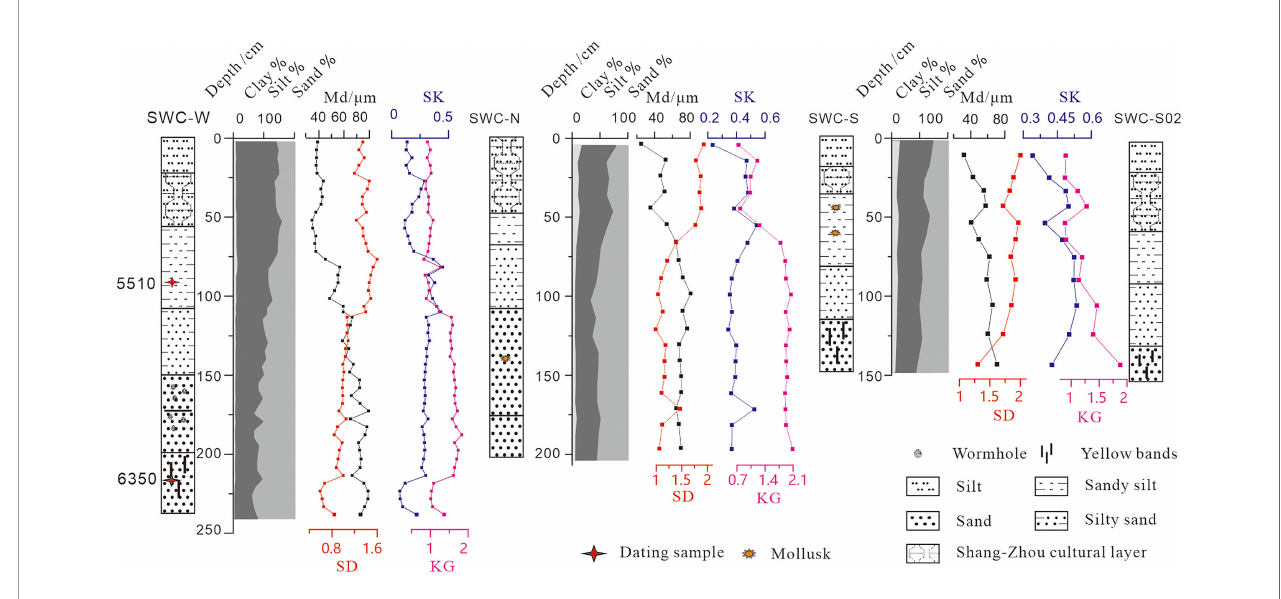
FIGURE 2 | Stratigraphy and curves of grain size parameters of the four pro fi les at the SWC